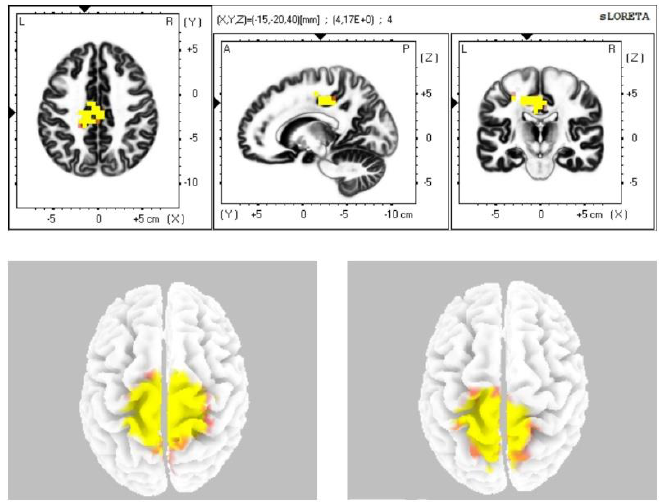
Figure 1. Statistically significant source activity in sLORETA imaging at the significance level p ≤ 0.05 for the alpha-2 band ( top image ), beta-1 band ( bottom-left image ), and beta-2 band ( bottom-right image ). Yellow and orange voxels indicate areas with increased electrical brain activity .